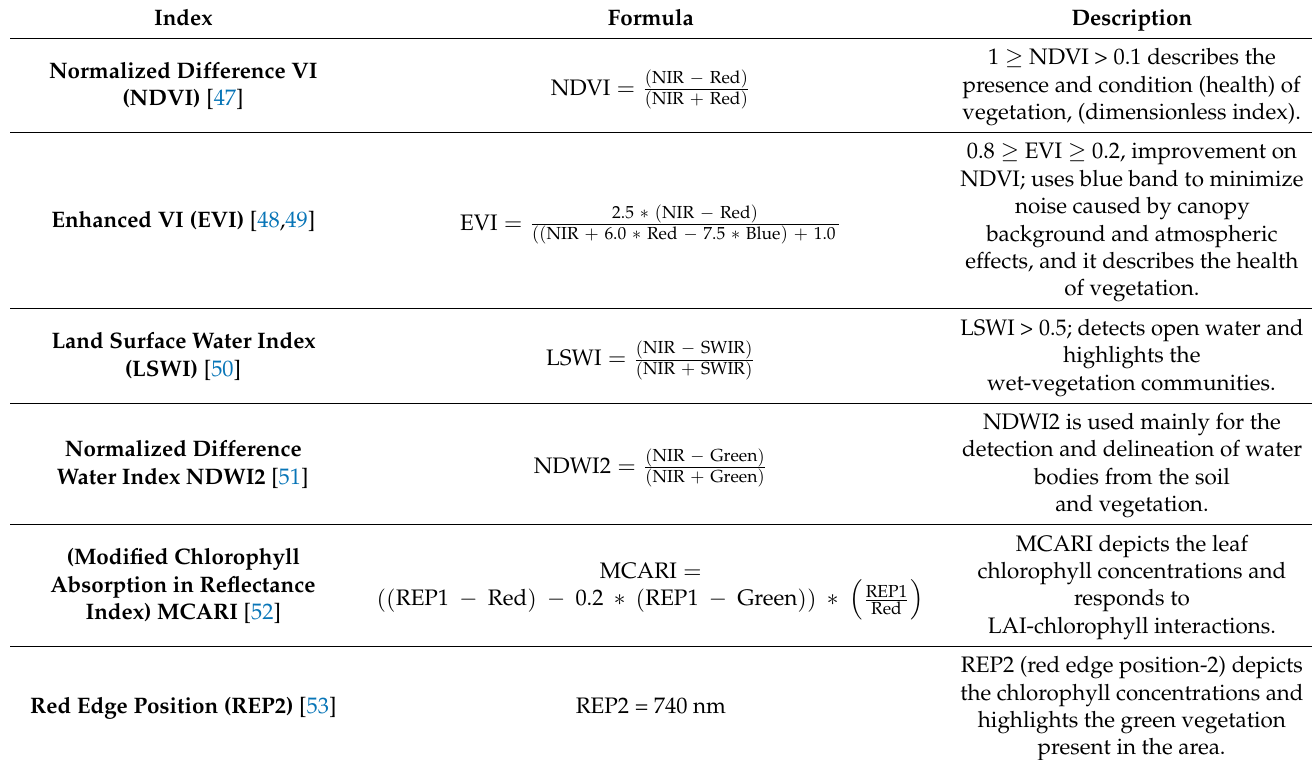
Table 1. List of vegetation and water indices used as a proxy for f PAR to model GPP.